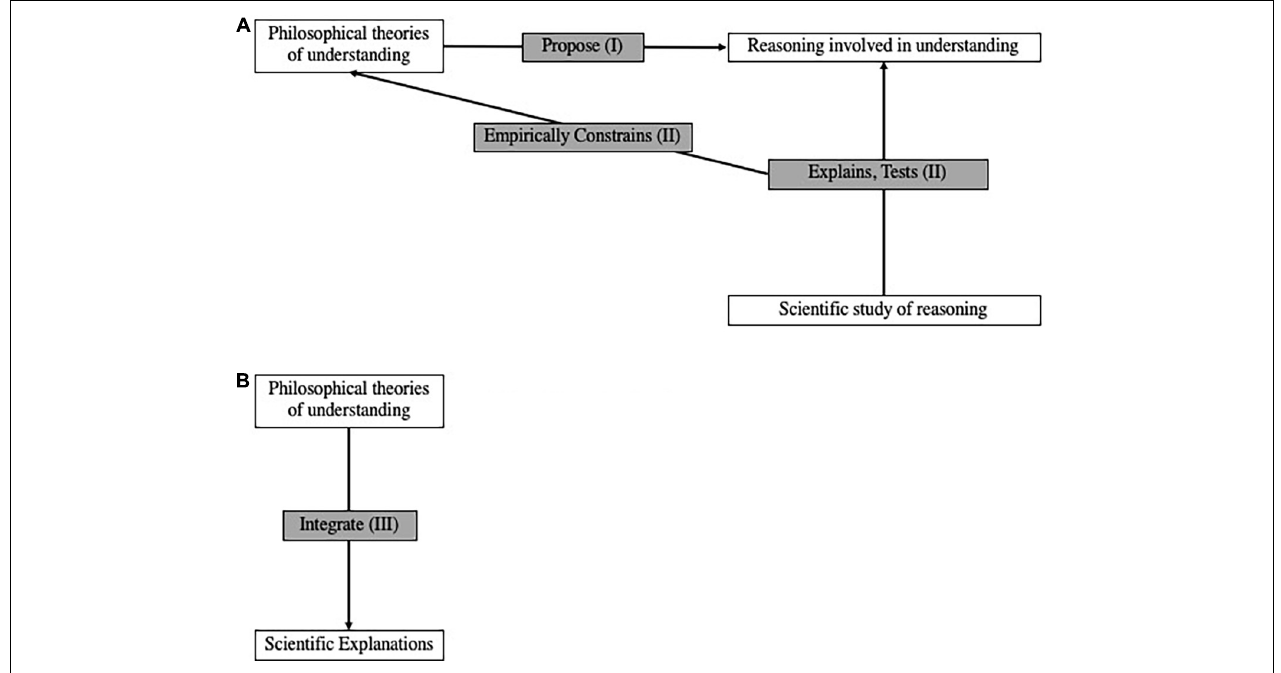
FIGURE 1 | Two ways to integrate philosophical work on understanding with relevant sciences. (A) Naturalized epistemology of understanding. (B) Understanding-based integration.